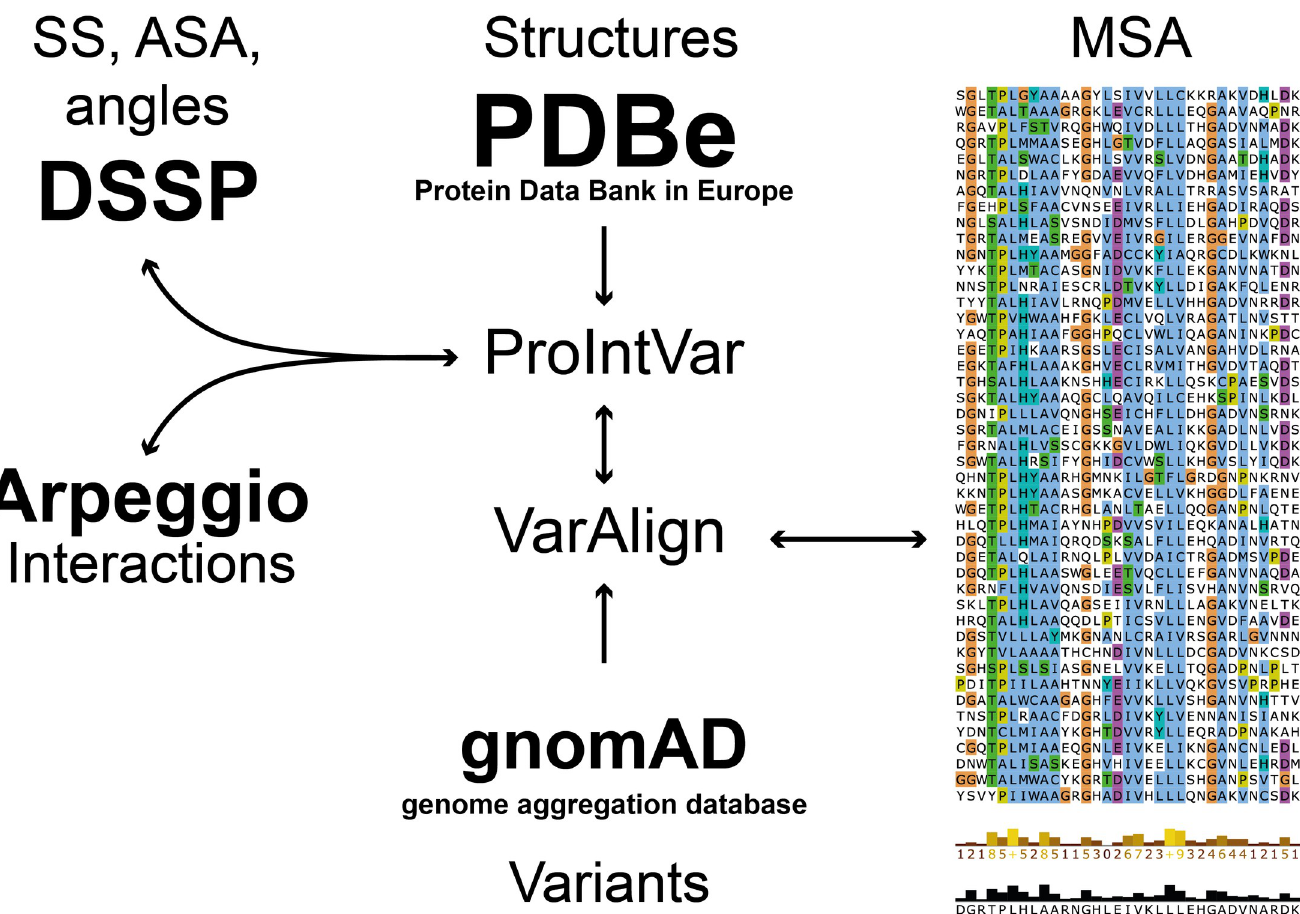
Fig 5. Diagram showing the main components of the pipeline. VarAlign retrieves variants found in human sequences in the MSA from gnomAD. ProIntVar retrieves structures from the PDBe and runs DSSP and Arpeggio to get secondary structure, accessible surface area and inter-atomic contacts information. Everything is mapped back to the residues and MSA columns